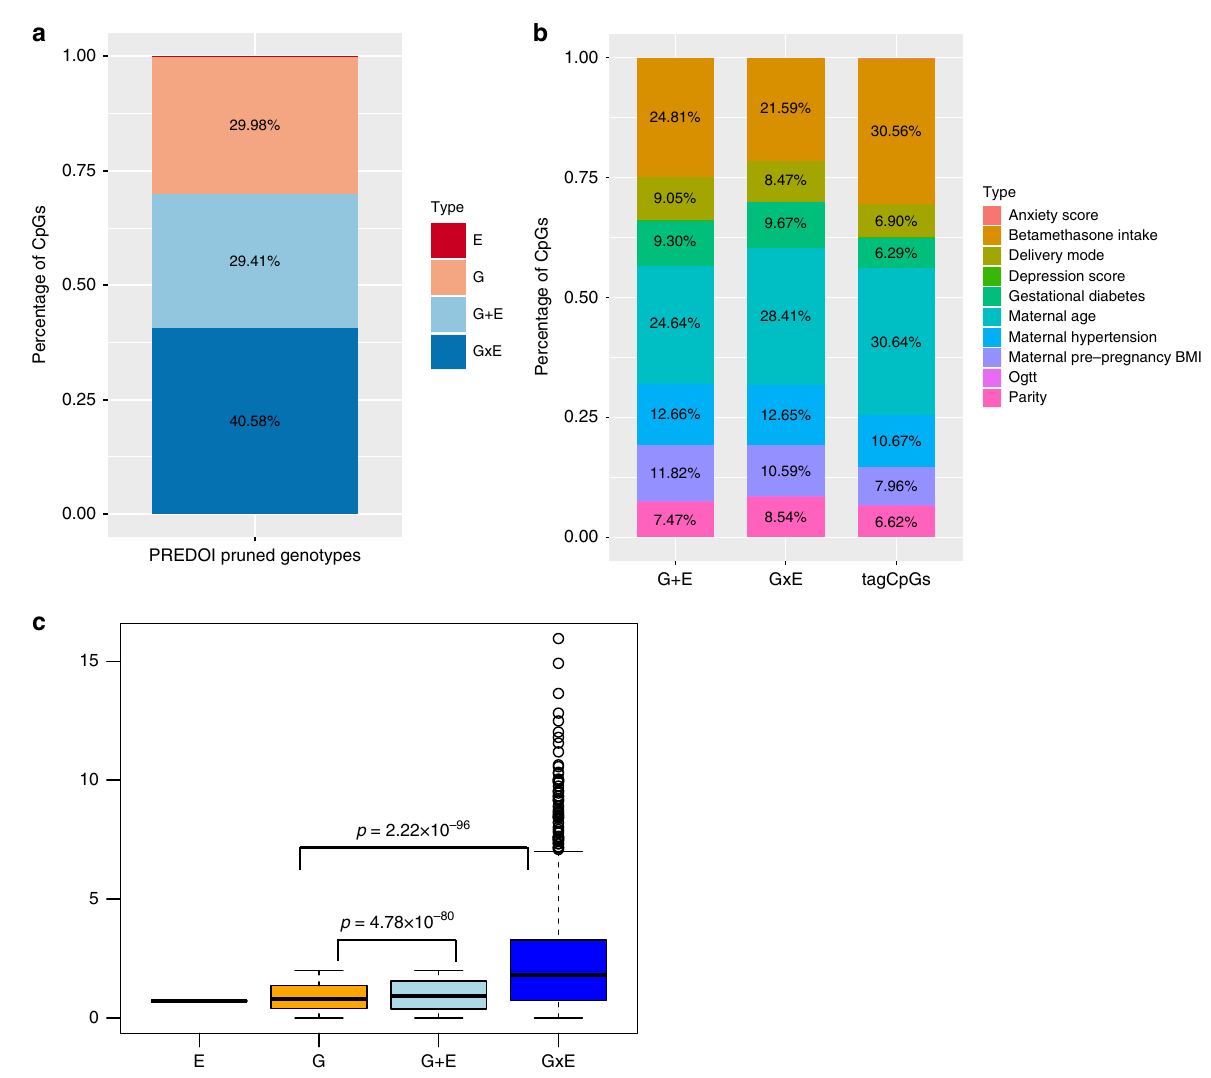
Fig. 2 VMR analysis in pruned PREDO I dataset. a Percentage of models (G, E, GxE or G + E) with the lowest AIC explaining variable DNA methylation using the PREDO I dataset with pruned SNPs. b Distribution of the different types of prenatal environment included in the E model with the lowest AIC (right), in the combinations yielding the best model GxE (middle), or the best model G + E models (left). To increase readability all counts <3% have been omitted. c DeltaAIC, i.e, the difference in AIC, between best model and next best model, strati fi ed by the best model. Y -axis denotes the delta AIC and the X -axis the different models. The median is depicted by a black line, the rectangle spans the fi rst quartile to the third quartile, whiskers above and below the box show the location of minimum and maximum beta-values. P -values are based on